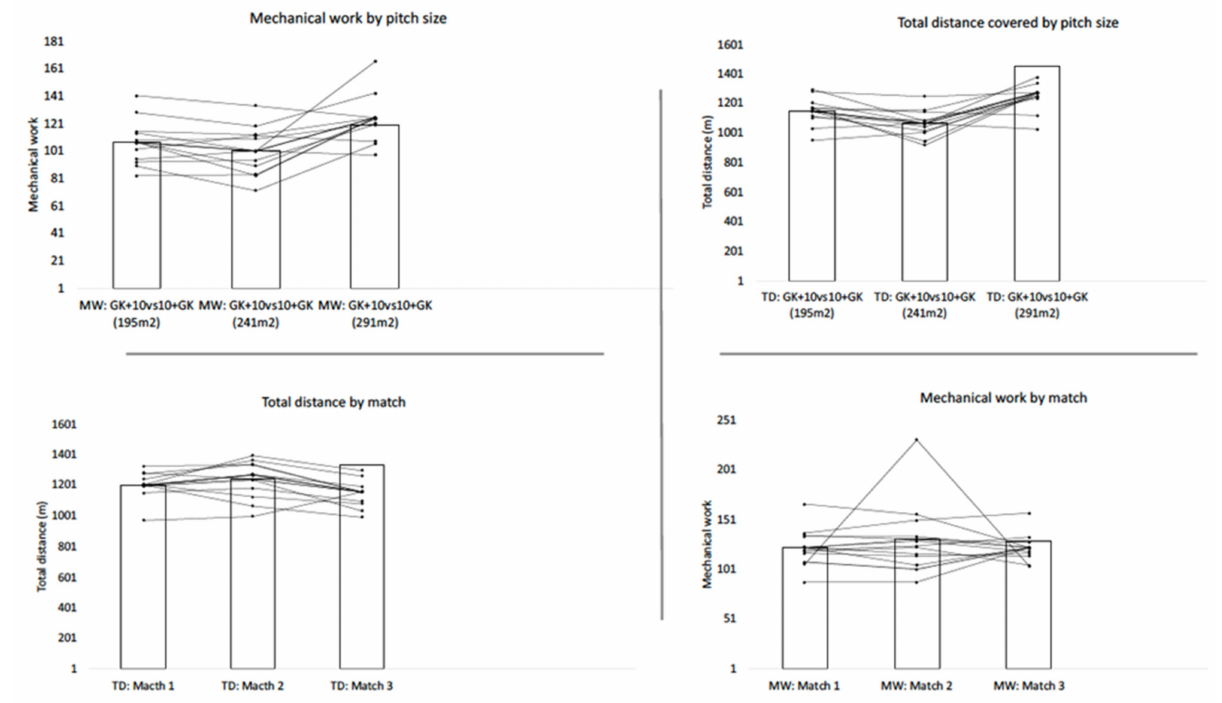
Figure 3. Players’ individual variation of locomotor demands (i.e., total distance and mechanical work) across the three official matches and GK + 10 vs. 10 + GK LSG conditions. The columns represent the average score for the